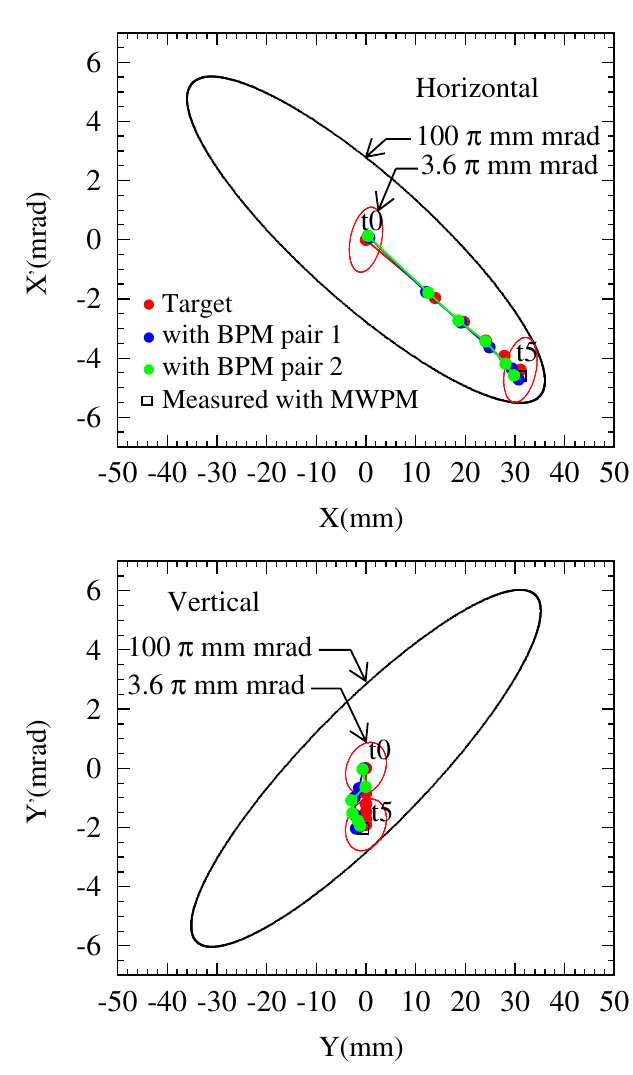
FIG. 7. (Color) Reconstructed phase space footprint obtained using Eq. (13) for a painting area of 100 (cid:1) mm mrad done separately in the horizontal (top) and vertical directions (bot- tom). Measurements took place at six different timings of the paint bump decay pattern covering the entire period of 500 (cid:2) s by delaying (or shifting) the bump patterns in steps of 100 (cid:2) s . Time stamp t0 corresponds to the start of painting, while t5 denotes the end. The legend is the same for both figures. The results from both pairs were consistent with each other and were found to nicely fit as expected on the linear red lines by reproducing all the intermediate states, although with slight deviations with some intermediate time stamps in the vertical direction. The error bars in the horizontal direction are included within the size of the symbols, as discussed in the latter part of Sec. VI (Fig.